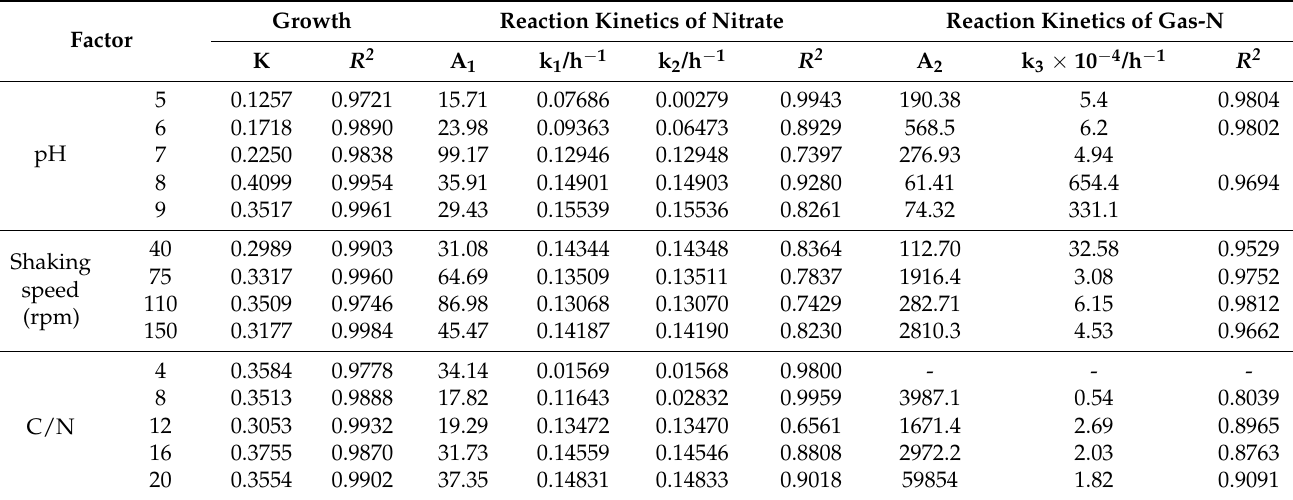
Table 1. Kinetic parameters of growth and nitrogen removal by P. aeruginosa